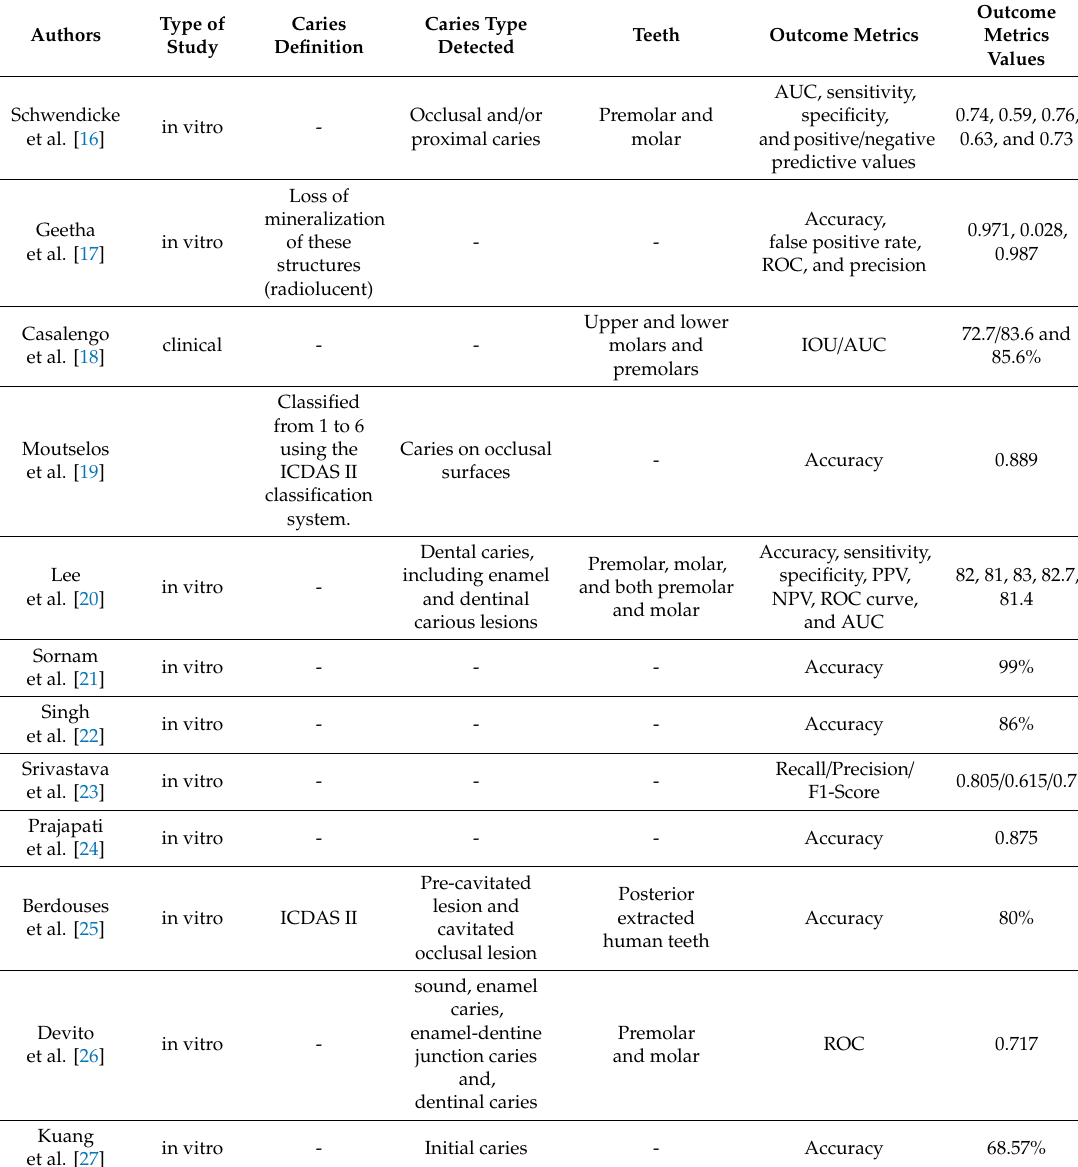
Table 3. Main data about caries of the included